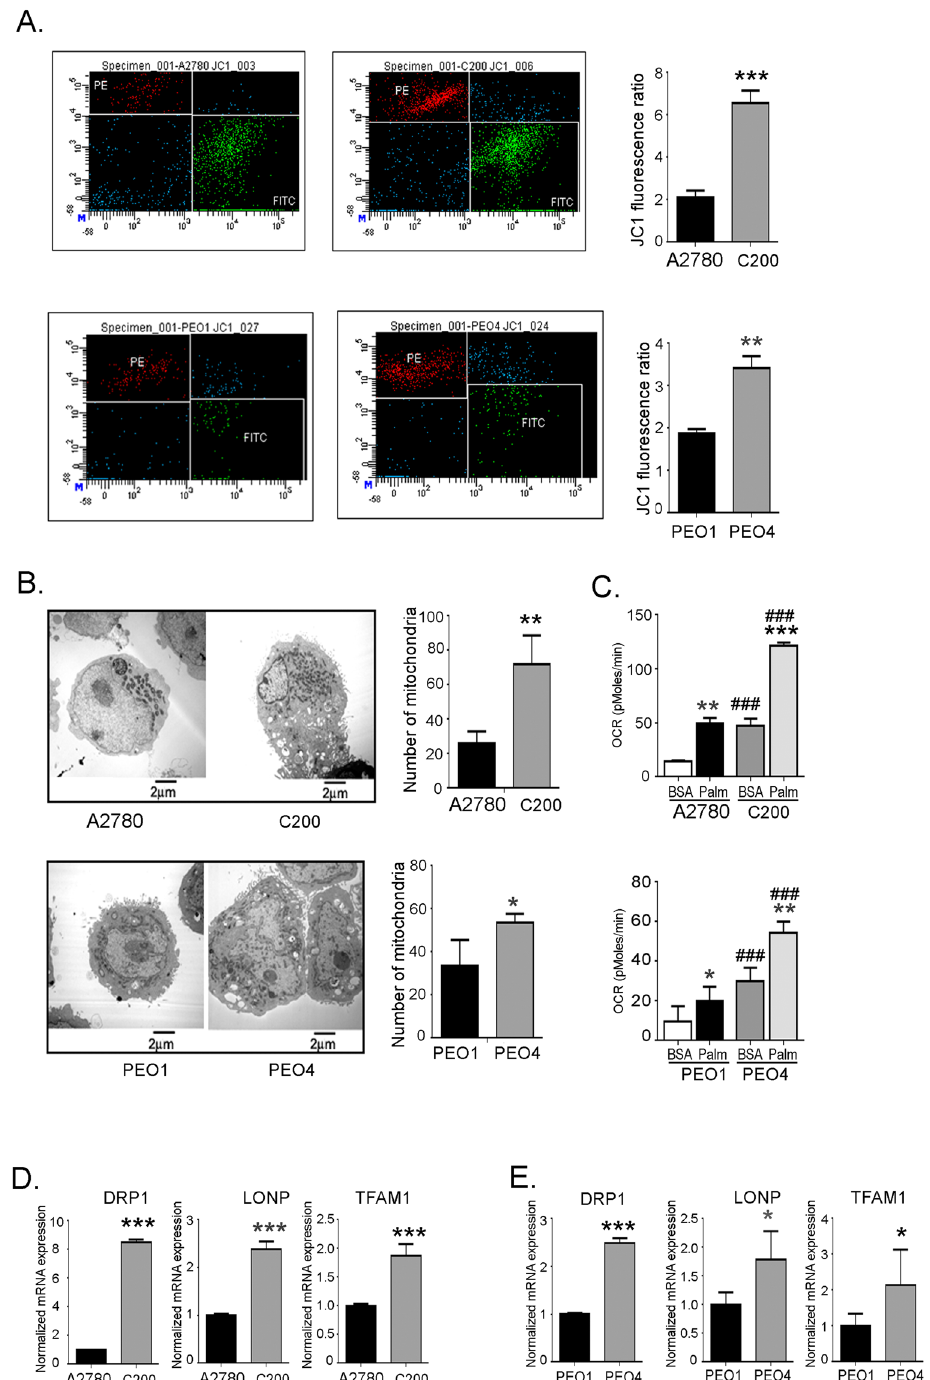
Figure 4. Chemoresistant ovarian cancer cells have increased mitochondrial function. ( A ) Mitochondrial potential of the cells was measured by JC-1 staining. The green fluorescence indicates de-energized mitochondria and the red fluorescence indicates energized mitochondria. Red to green fluorescence intensity ratio indicated increased mitochondrial potential and is represented as a bar graph. The experiment was performed in triplicates and replicated twice. *** p < 0.001, ** p < 0.01, chemoresistant cells (C200 and PEO4 compared to respective chemosensitive cells [A2780 and PEO1]). ( B ) Representative electron microscope pictures of mitochondria. Cells were washed, fixed, embedded in Spurr’s resin and 90 nm sections were placed on 200 mesh copper grids and then examined under Philips Transmission Electron Microscope 208. Mitochondrial count was performed by counting mitochondria per high power field from 15 fields per cell line. ** p < 0.01, * p < 0.05 chemoresistant cells (C200 and PEO1 compared to respective chemosensitive cells [A2780 and PEO1]). ( C ) Palmitate-linked OCR representing fatty acid oxidation. Bovine Serum Albumin (BSA) is the vehicle control for palmitate. *** p < 0.001, ** p < 0.01, * p < 0.05 palmitate compared to BSA in